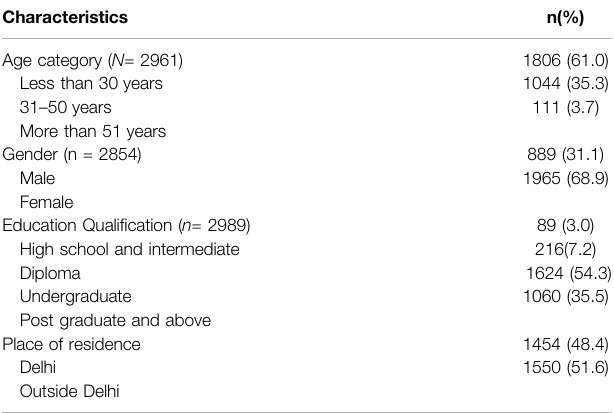
TABLE 1 | | Demographic pro fi le of the healthcare workers ( N = 3004).